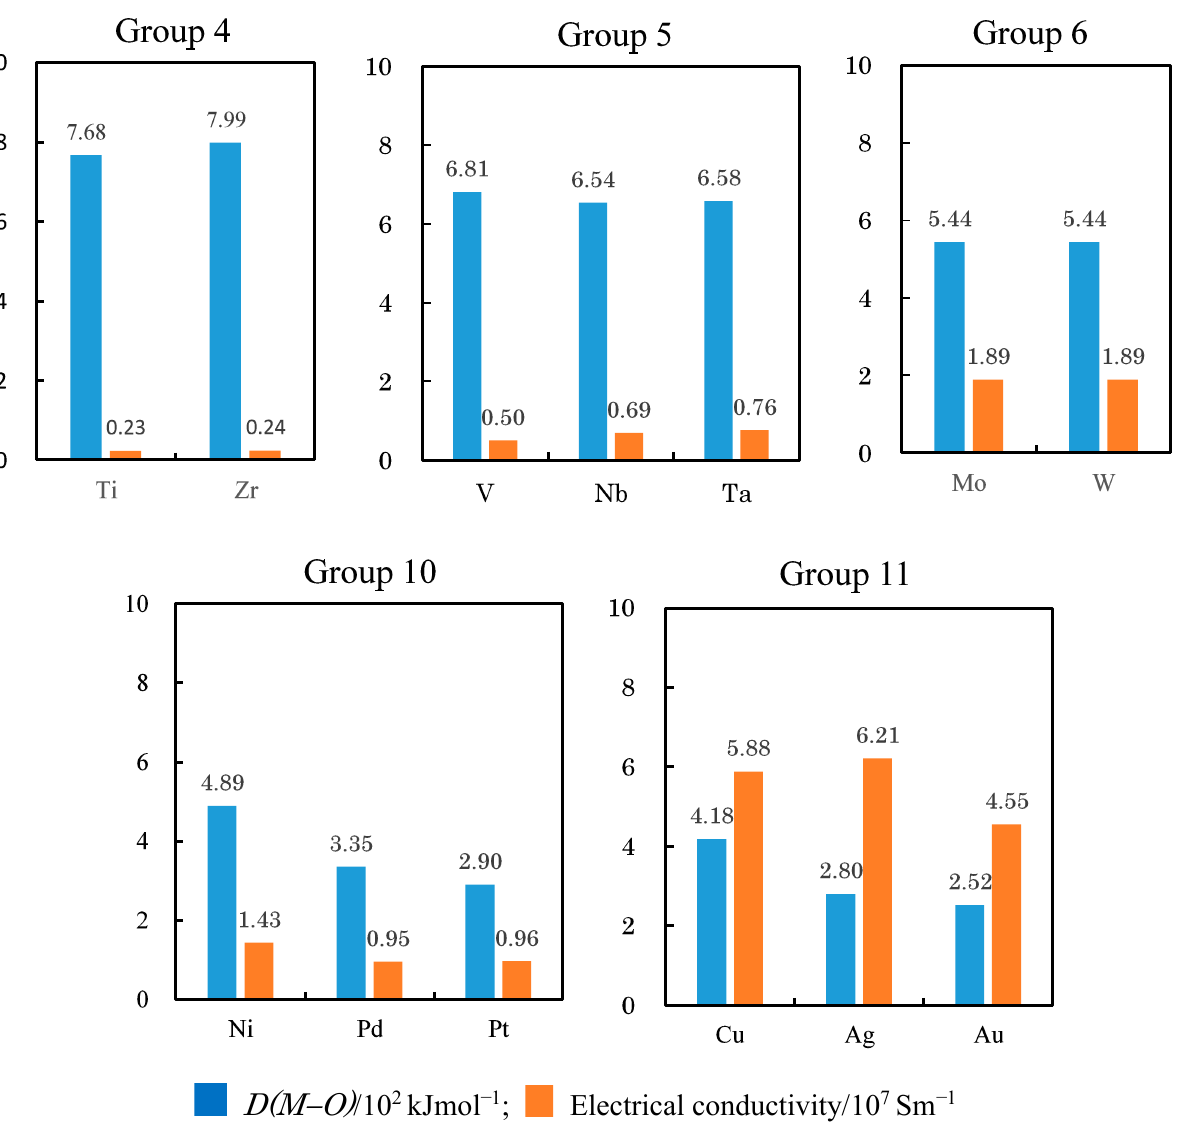
Figure 13. The relationship between D(M–O) and electrical conductivity values for metals in groups 4, 5, 6, 10, and 11.